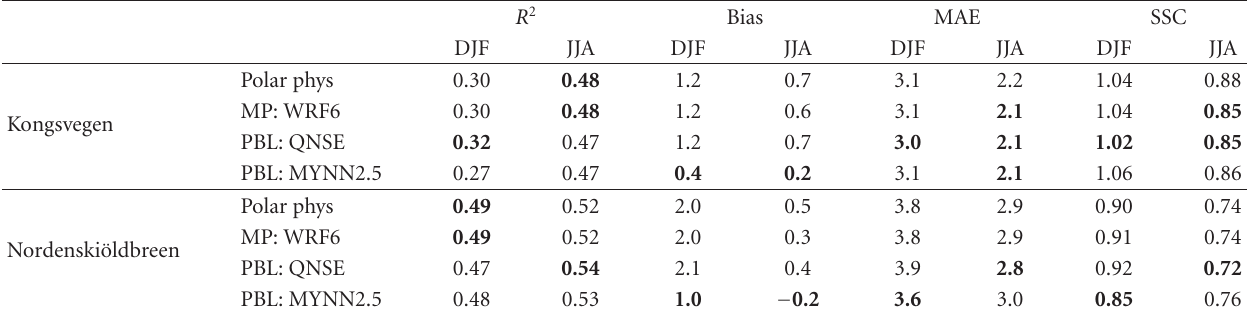
Table 10: Wind speed in 2.7km resolution. Bold numbers indicate the best result for each AWS. Vestfonna data are not used here because of the lack of data during the chosen